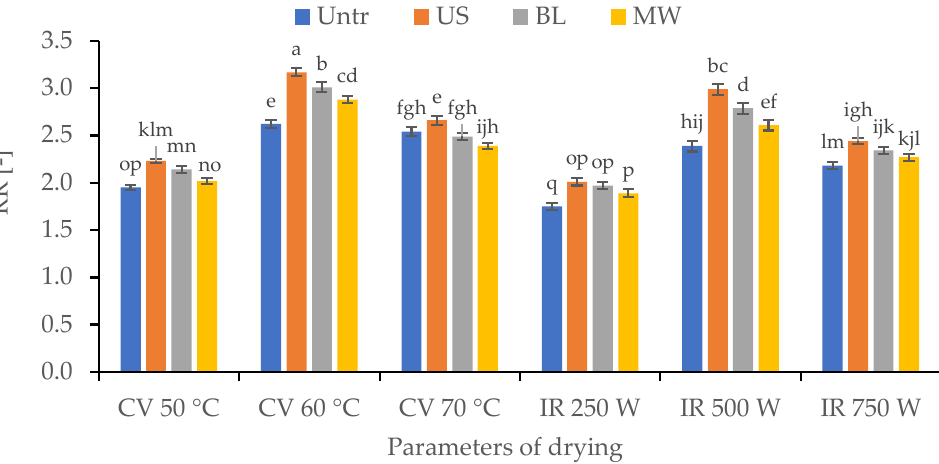
Figure 3. Effect of different pretreatments (Untr: control, US: ultrasonic, BL: blanching, MW: microwave) and different conditions of drying methods temperature (50, 60, and 70 °C) for CV drying and infrared power (250, 500, and 750 W) on rehydration rate (RR) of dried terebinth. Bars show the differences between the sample with six replicates and the different letters differ significantly from each other at ( p < 0.05) as determined by the LSD test.